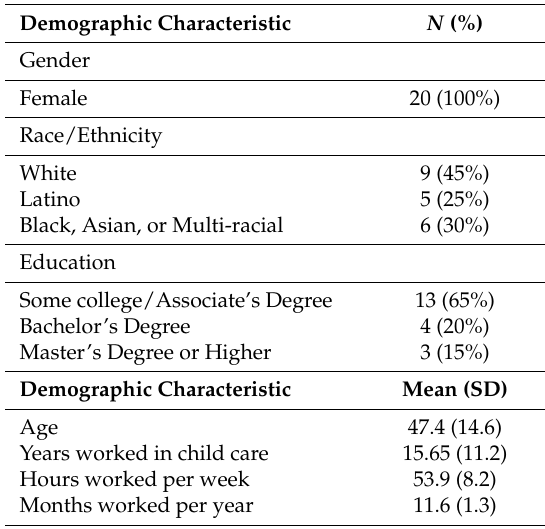
Table 2. FCCH Director Demographics, N =